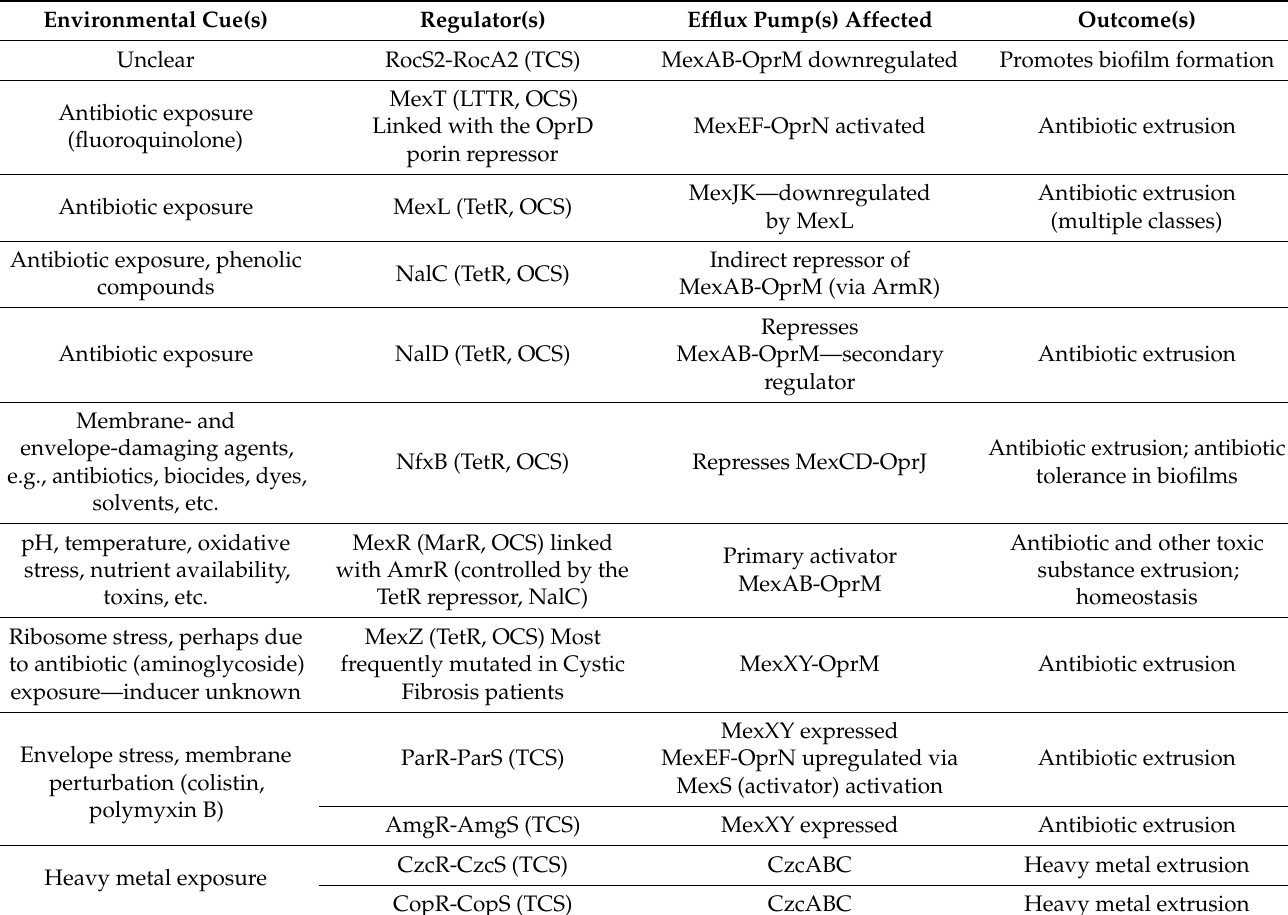
Table 2. Two-component system and one-component system regulators of RND efflux pumps in P. aeruginosa